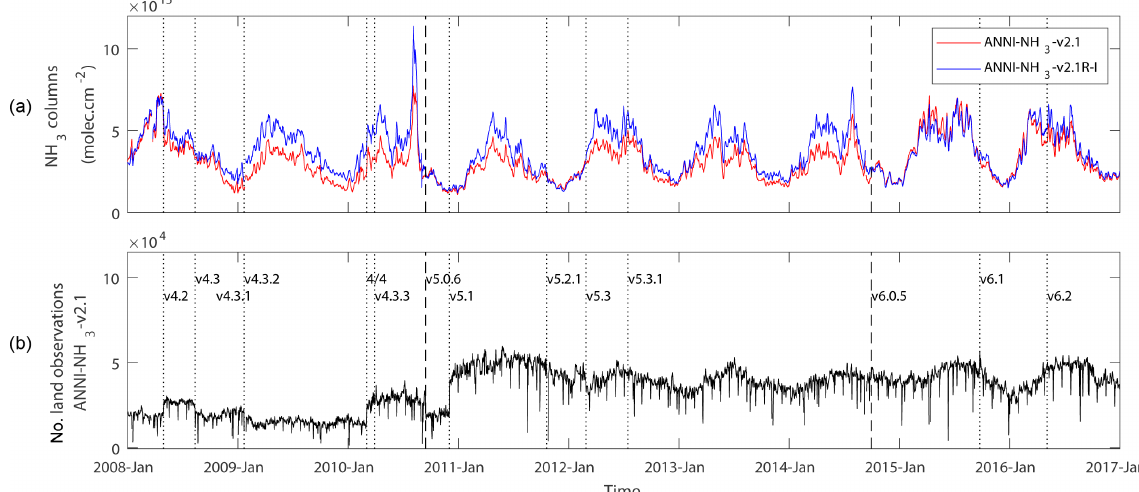
Figure 3. (a) 5-day moving average time series of the morning NH 3 columns (moleccm − 2 ) over the Northern Hemisphere for the near-real- time retrieval (ANNI-NH 3 -v2.1, red) and the reanalysed retrieval (ANNI-NH 3 -v2.1R-I, blue). (b) Number of land observations available for the Northern Hemisphere using the Eumetsat L2 data. The corresponding version number is indicated as a function of